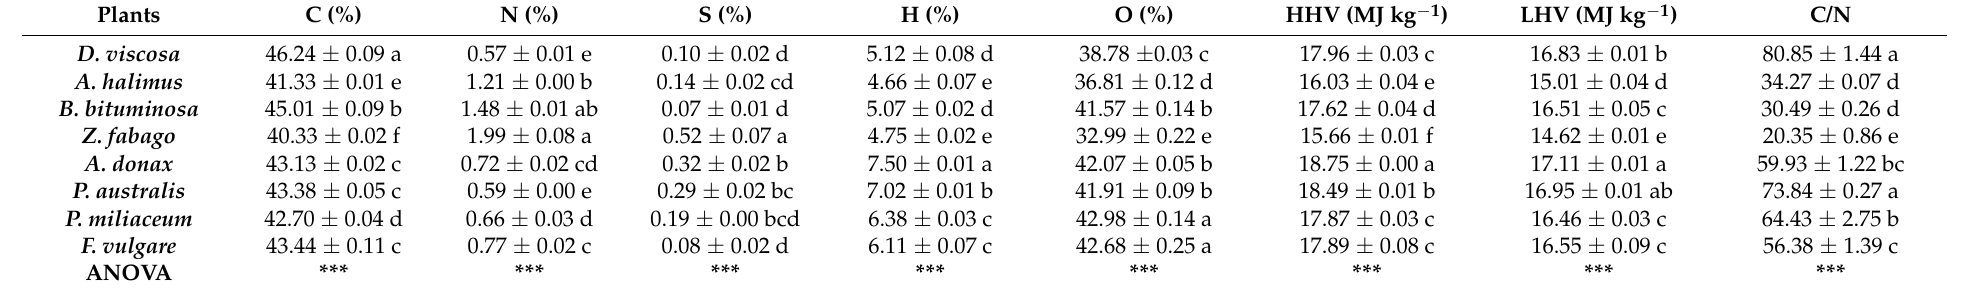
Table 3. Elemental analysis, higher heating value (HHV), lower heating value (LHV) and C/N ratio of the plants (average values ± se; n = 2). Plants